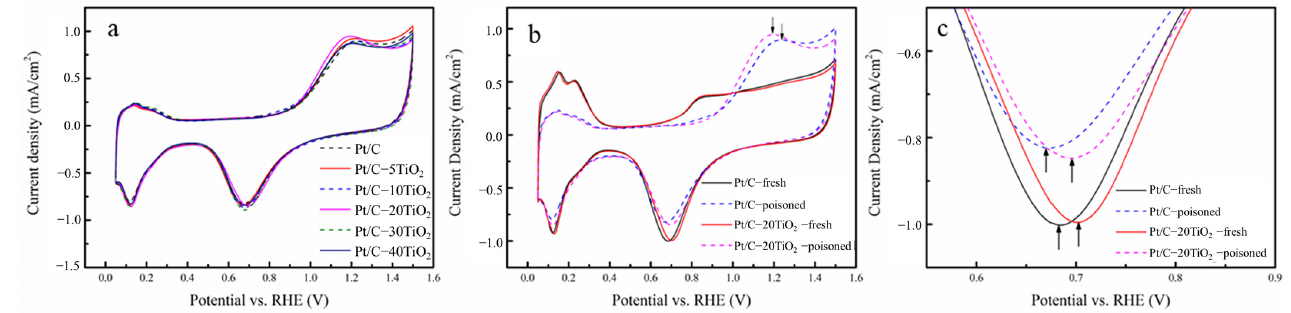
Figure 4. CV curves in Ar-saturated 0.1 M HClO 4 solution of ( a ) all catalysts after SO 2 poisoning, ( b ) Pt/C and Pt/C − 20TiO 2 before and after poisoning, and ( c ) corresponding magnification at oxide reduction potential region.